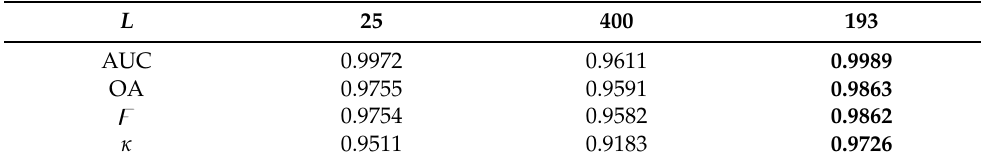
Table 6. The quantitative comparison for AUC, OA, F-score (denoted (cid:122) ), and Kappa coefficient (denoted κ ) with different L s for the Indian Pine data. Bold numbers indicate the highest values in each